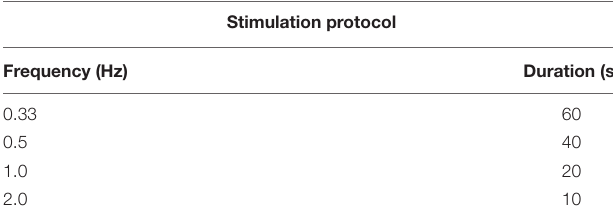
TABLE 1 | Stimulation protocol for direct and indirect stimulation of